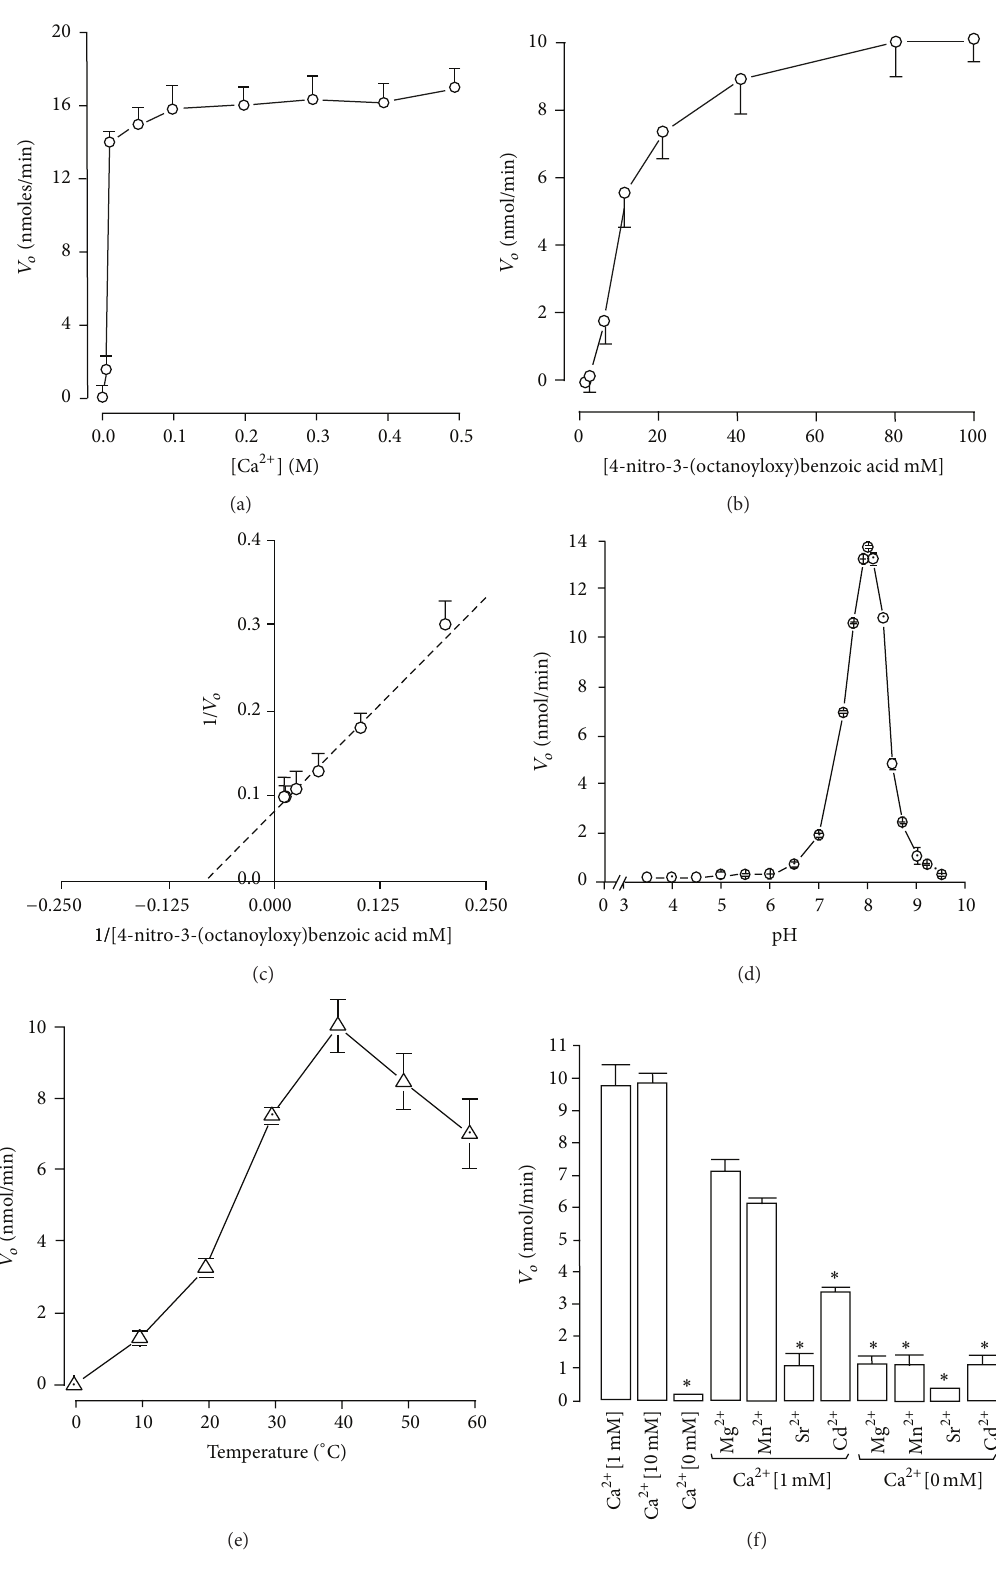
Figure 5: Kinetic analysis of Bp-13 PLA 2 activity. (a) Influence of calcium ion on PLA 2 activity; (b) effect of substrate concentration on the kineticsofBp-13PLA 2 ;(c)Lineweaver-Burk(double-reciprocal)plotofBp-13PLA 2 ;(d)optimalpHforPLA 2 activity;(e)optimaltemperature for PLA 2 activity; (f) influence of ions (10mM each) on PLA 2 activity in the absence or presence of 1mM and 10 mM Ca 2+ . The results are the mean ± SEM of five experiments. ∗ 𝑃 < 0.05 when compared with control values. ANOVA and followed by Mann-Whitney test for comparison between two